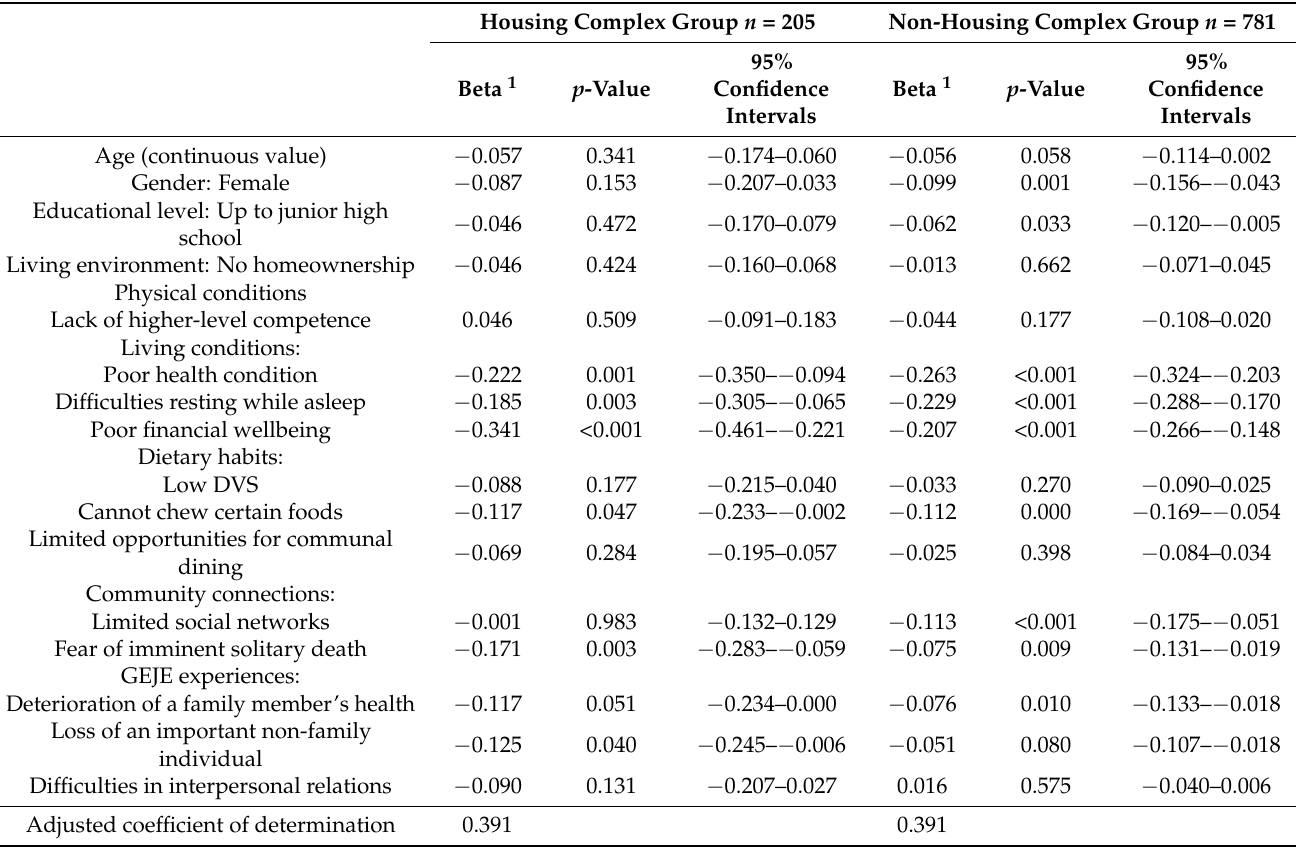
Table 3. Factors related to Subjective